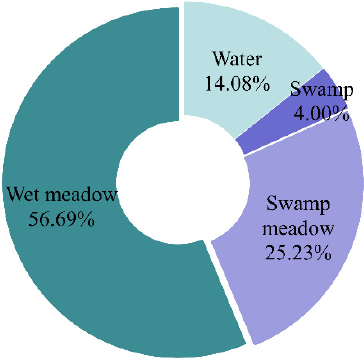
Figure 7. Proportions of the wetland types in Maqu in 2020.